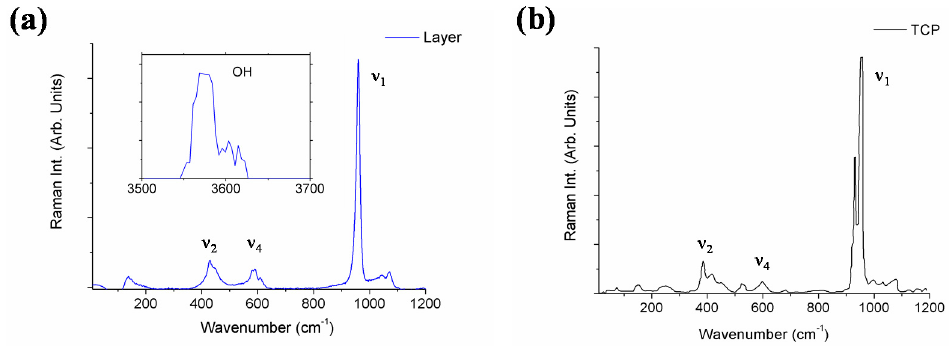
Figure 3. Micro-Raman spectra collected on the surface of the sample after a one-month immersion in SBF ( a ). The standard TCP Raman spectrum is also presented for comparison purposes ( b ).